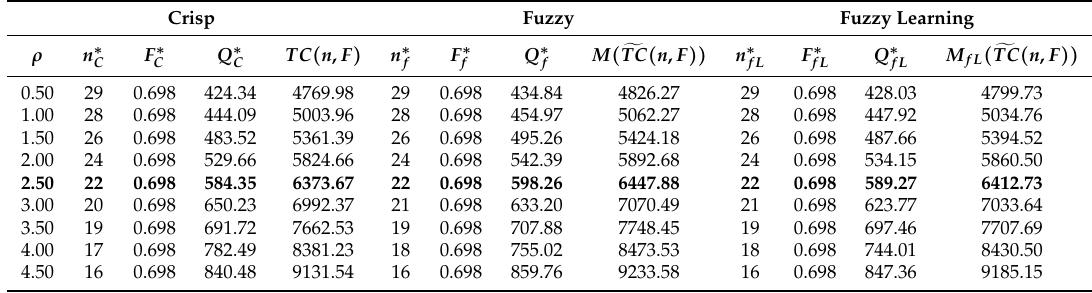
Table 5. Effect of promotional effort ( ρ ) on the crisp, fuzzy, and fuzzy-learning models. Crisp Fuzzy Fuzzy